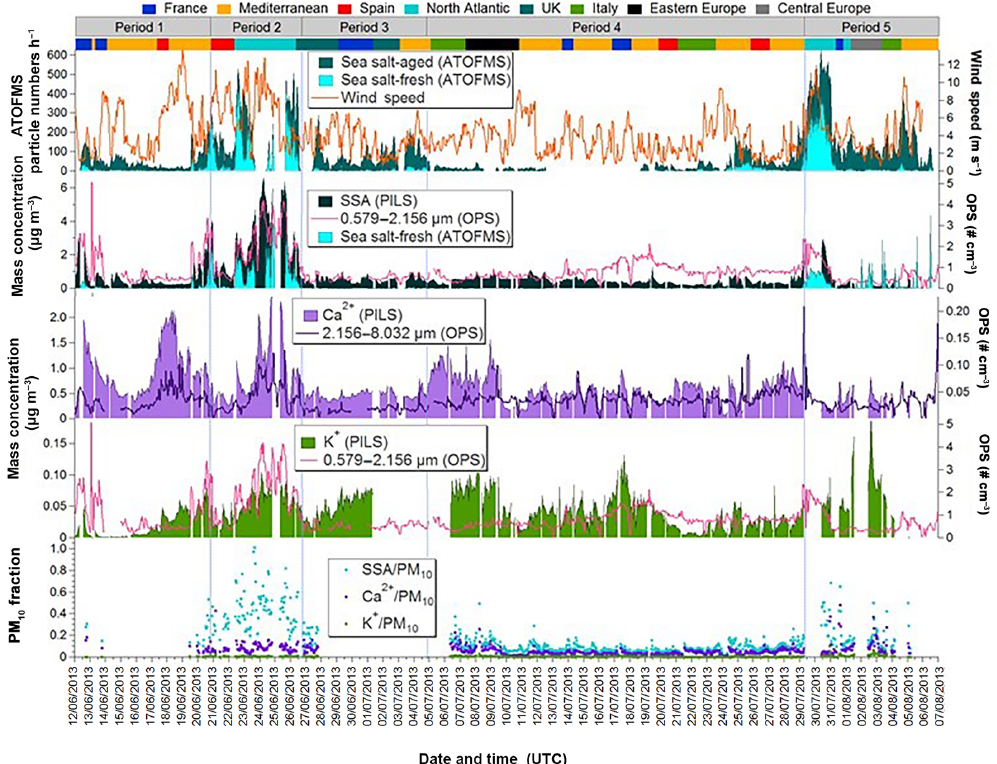
Figure 9. Time series of hourly ATOFMS sea salt particle numbers, OPS number concentrations, PILS-IC SSA (sea salt aerosol), Ca + , K + and ATOFMS fresh sea salt mass concentrations, and PM 10 fractions observed during ADRIMED and SAF-MED. Dates are